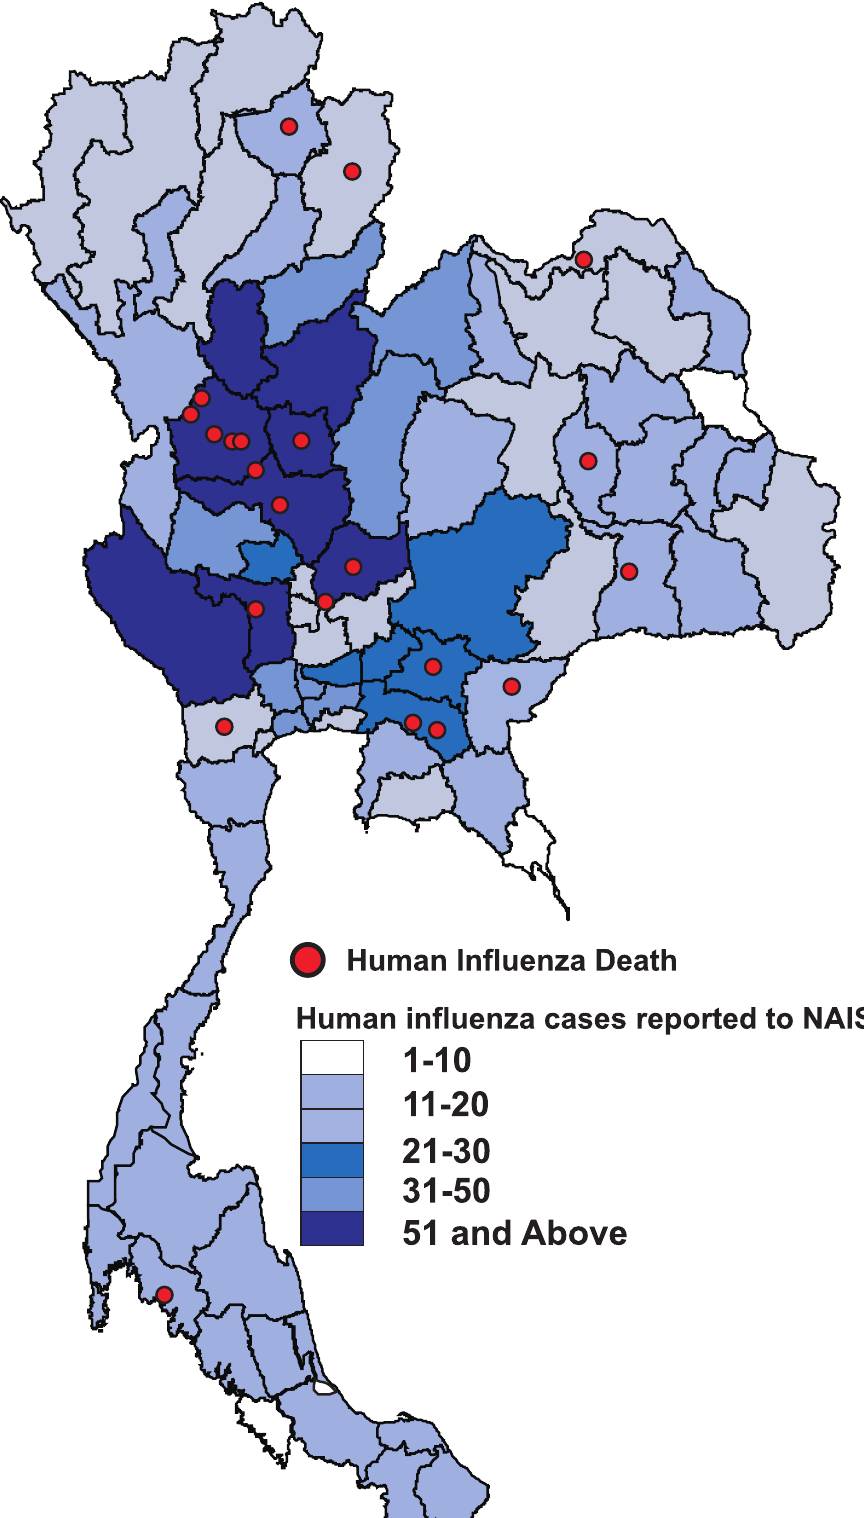
Figure 2. Geographic distribution of human influenza cases.